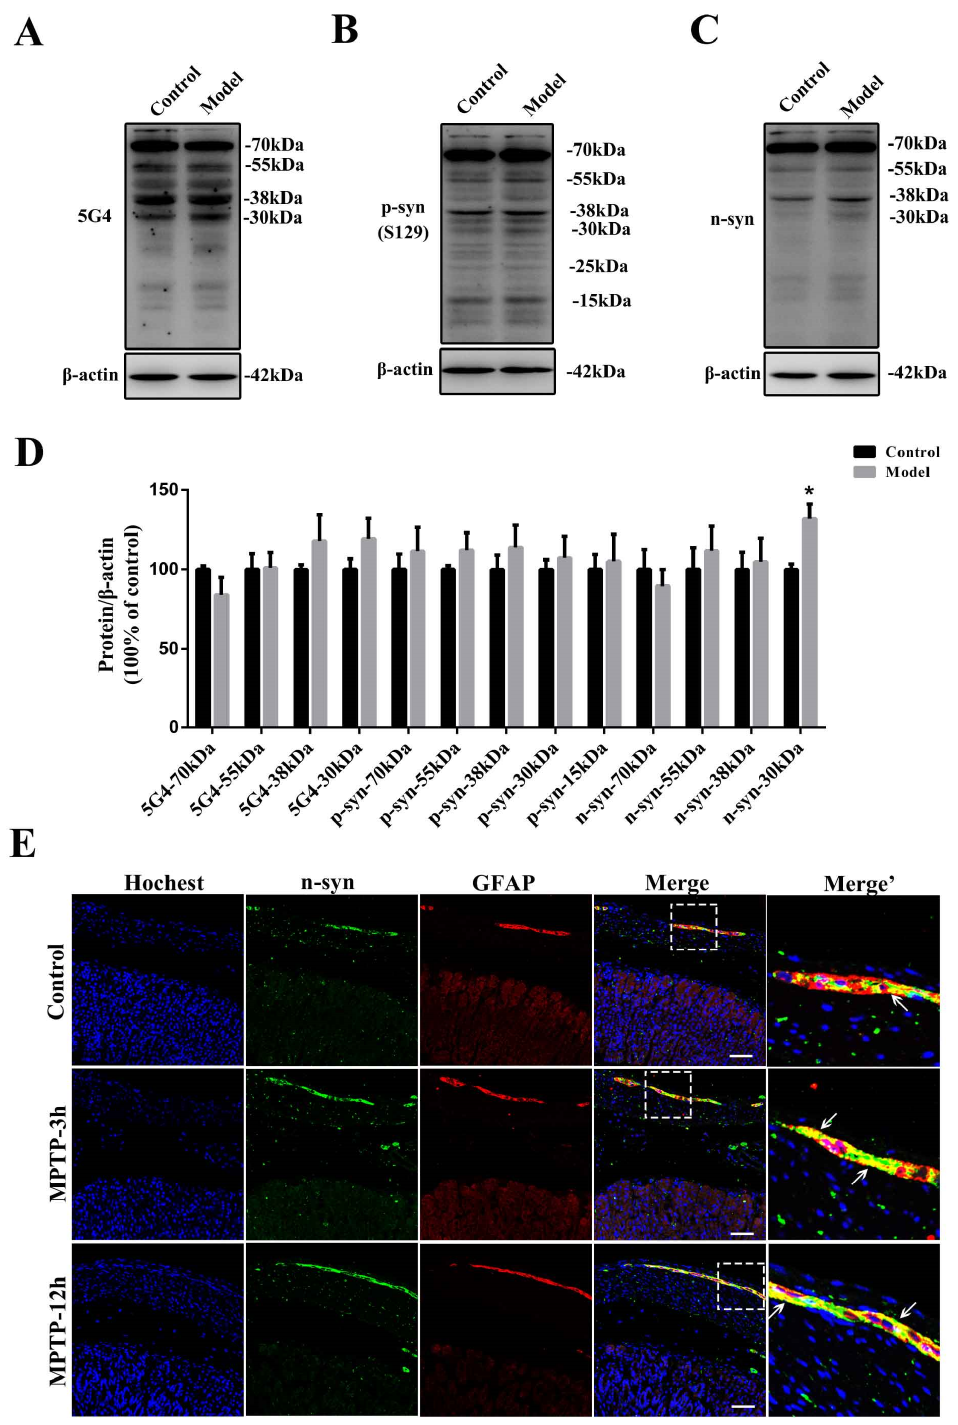
Figure 10. EGCs could be the initial cells contributing to the synucleinopathies. Representative protein bands of stomachs dissected from 12 h MPTP-exposed mice detected using ( A ) 5G4, ( B ) anti-p- syn, ( C ) anti-n-syn, and β-actin antibodies are shown. ( D ) A histogram representing the quantitative analysis of different forms of α-synuclein levels of stomachs dissected from 12 h MPTP-exposed mice detected using 5G4, anti- p-syn (S129), and n-syn antibodies normalized to β-actin protein levels is shown ( n = 4). ( E ) Nitrated α-synuclein (detected using the anti-n-syn antibody) localization in stomach sections from control and model mice (3 h and 12 h MPTP-exposed mice), additionally stained for GFAP (scale bar = 50 μm). White arrows refer to n-syn and GFAP co-expression in the EGCs. The data are presented as the means ± SEM, * p < 0.05 compared with the control group.